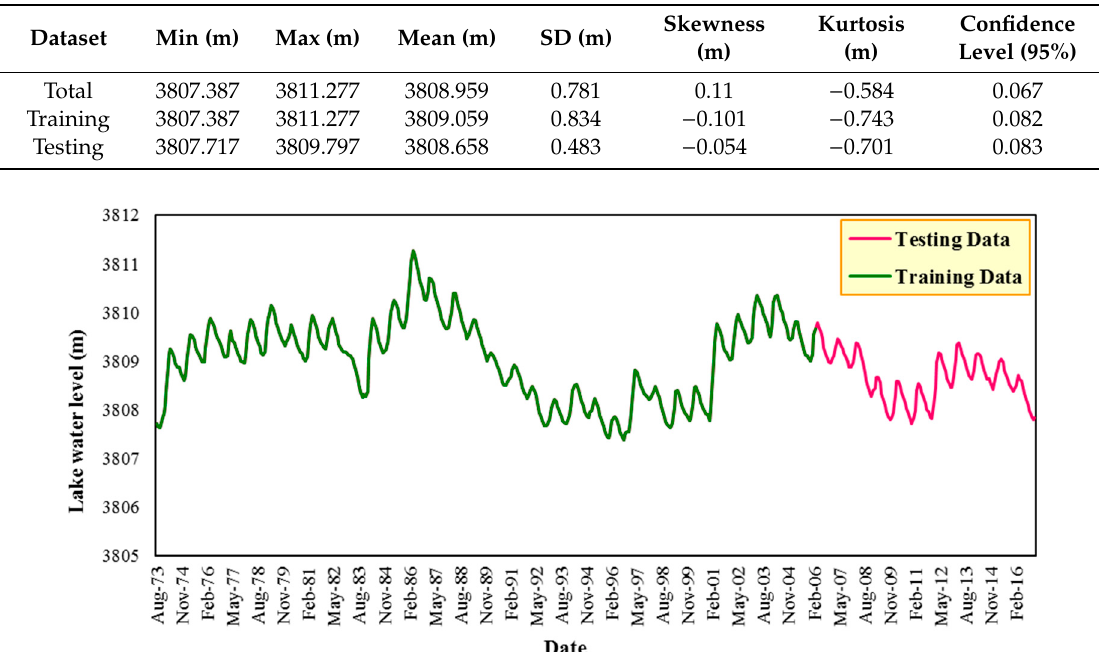
Figure 2. Time series of Titicaca water level for the duration of the study period (1973–2017).